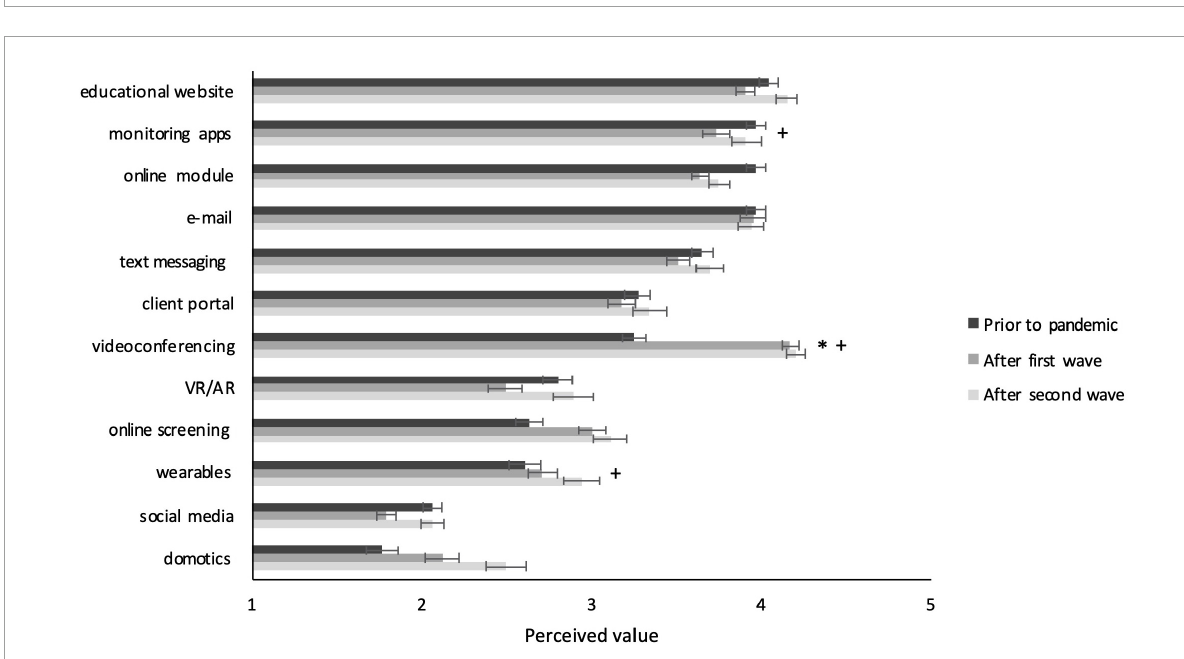
only experienced barriers: Empathic interaction referred to issues with the ability to establish an empathic interaction online and missing non-verbal cues and Client-related barriers